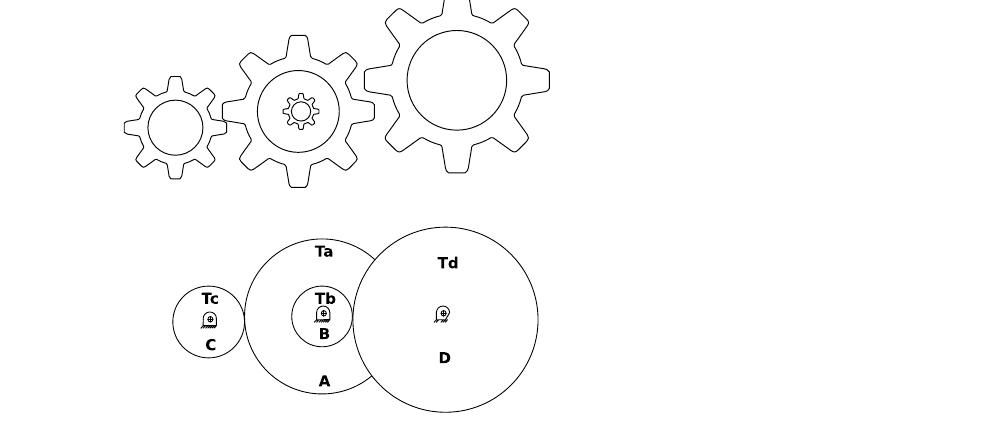
Figure 14. Schematic of gear train.